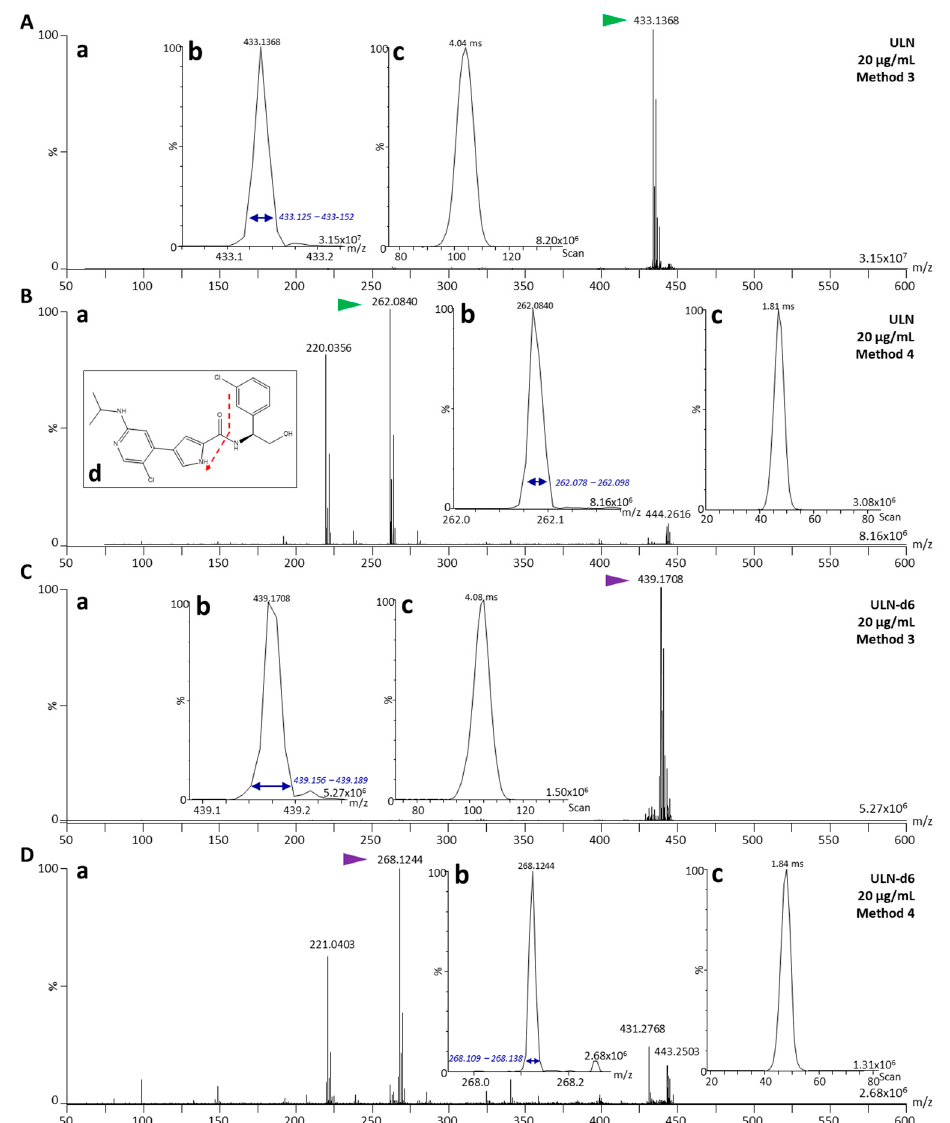
Figure 3. Mass spectrometric (MS) characterization of the reference compound, ulixertinib (ULN), and its internal standard (IS), ULN-d 6 , as parent compounds or as fragmented compounds. ( A ) Mass spectrum of the parent ion of ULN ( m / z 433.14, ( A ( a ))), with a zoomed view on the monoisotopic ion peak of ULN (green arrow, ( A ( b ))) and the corresponding extracted ion mobilogram (XIM) with the mobility peak of intact ULN (( A ( c )), extracted from the m / z range in blue arrows). ( B ) Tandem mass spectrum (MS/MS spectrum) of ULN ( m / z 433.14, ( B ( a ))), with a zoomed view on the monoisotopic ion peak of the fragment at m / z 262.08 (green arrow, ( B ( b ))) and the corresponding XIM with the mobility peak of the ULN major fragment (( B ( c )), extracted from the m / z range in blue arrows). The fragmentation pattern is given in ( B ( d )). ( C ) Mass spectrum of the parent ion of ULN-d 6 ( m / z 439.17, ( C ( a ))), with a zoomed view on the monoisotopic ion peak of ULN-d 6 (purple arrow, ( C ( b ))) and the corresponding XIM with the mobility peak of intact ULN-d 6 (( C ( c )), extracted from the m / z range in blue arrows). ( D ) MS/MS spectrum of ULN-d 6 ( m / z 439.17, ( D ( a ))), with a zoomed view on the monoisotopic ion peak of the fragment at m / z 268.12 (purple arrow, ( D ( b ))) and the corresponding XIM with the mobility peak of the ULN-d 6 major fragment (( D ( c )), extracted from the m / z range in blue arrows). Analyses of parent compounds were acquired using Method 3 (selection of m / z 433 in the quadrupole and no fragmentation). Analyses of fragmented compounds were acquired using Method 4 (selection of m / z 433 in the quadrupole and fragmentation with a collision energy of 32